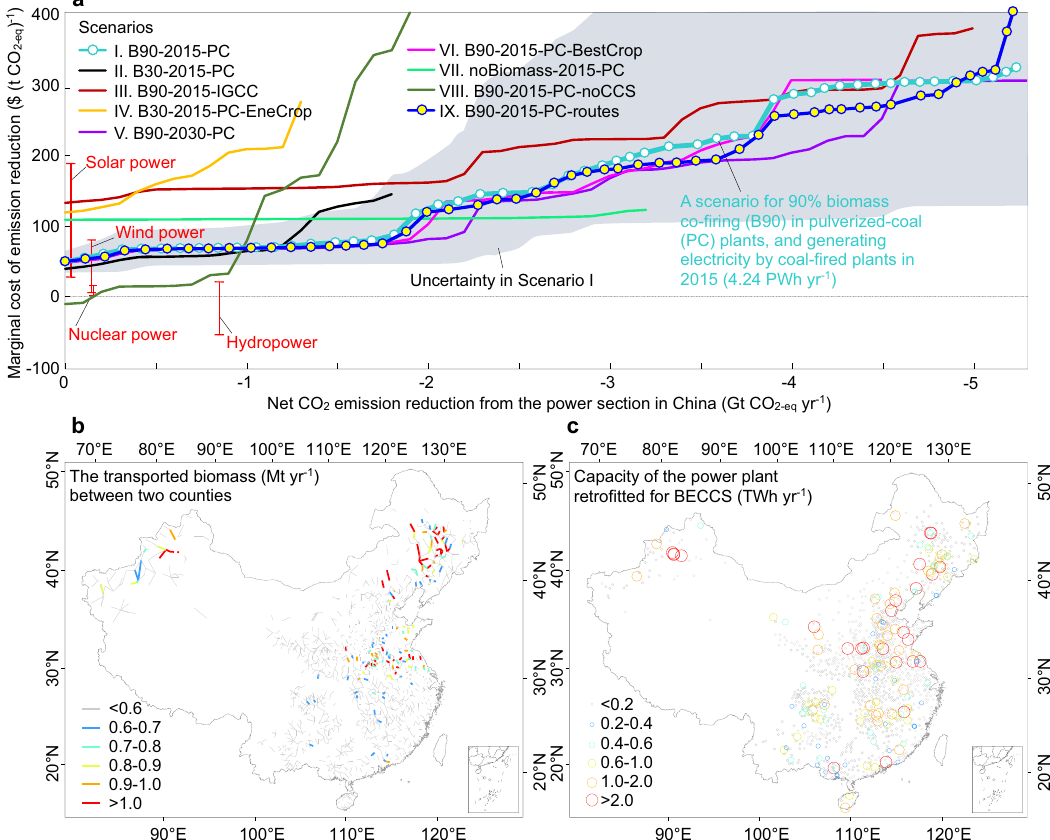
Fig. 3 Marginal cost curves of BECCS in China. a Marginal cost curves of BECCS in scenarios include: “ B90-2015-PC ” for retro fi tting pulverized-coal (PC) plants under 90% biomass co- fi ring (B90) to generate electricity in 2015, “ B30-2015-PC ” for 30% biomass co- fi ring (B30), “ B90-2015-IGCC ” for transferring PC to integrated gasi fi cation combined cycle (IGCC) plants, “ B30-2015-PC-EneCrop ” for using dedicated energy crops (EneCrop) only, “ B90- 2030-PC ” for generating the projected electricity in 2030, “ B90-2015-PC-BestCrop ” for using the best-yield crops (BestCrop), “ noBiomass-2015-PC ” for using coal in power plants equipped with CCS, “ B90-2015-PC-noCCS ” for biomass co- fi ring without CCS and “ B90-2015-PC-routes ” for considering the routes of biomass transportation between each county and the nearest ten counties. CO 2 emission reduction by hydropower, wind, solar, and nuclear power in China in 2015 and the marginal costs are shown as red lines. Uncertainties in the marginal costs in the scenario of “ B90-2015-PC ” estimated from Monte Carlo simulations are shown as the shaded area. The marginal costs of retro fi tting 300, 600, … , 15,000 of 15,244 power plants in the scenario of “ B90-2015-PC ” or retro fi tting 300, 600, … , 15,000 of 15,159 power plants in “ B90-2015-PC-routes ” are shown by circles. b Routes of the biomass transportation between counties to abate 2 Gt CO 2-eq year − 1 in “ B90-2015-PC-routes ” . c Spatial distribution of the retro fi tted power plants for BECCS